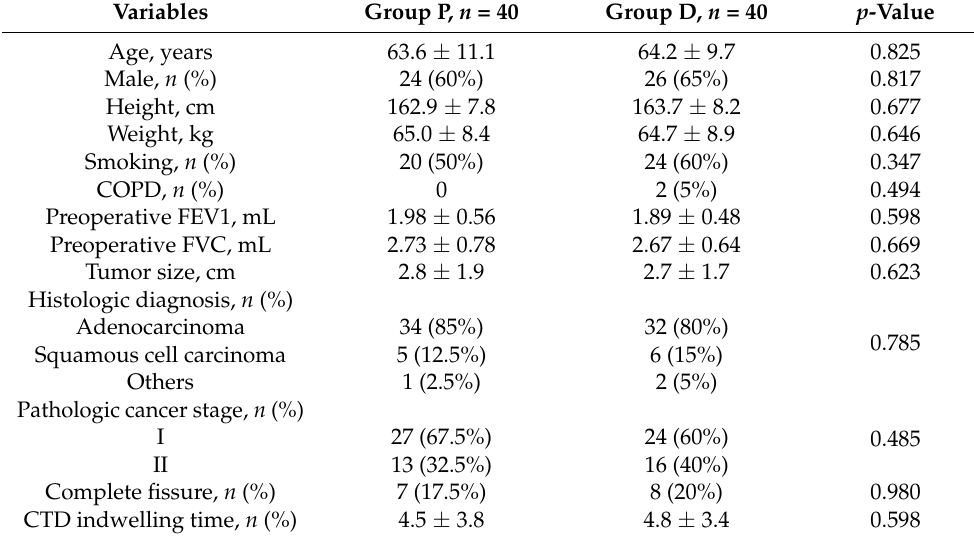
Table 1. Baseline characteristics between two